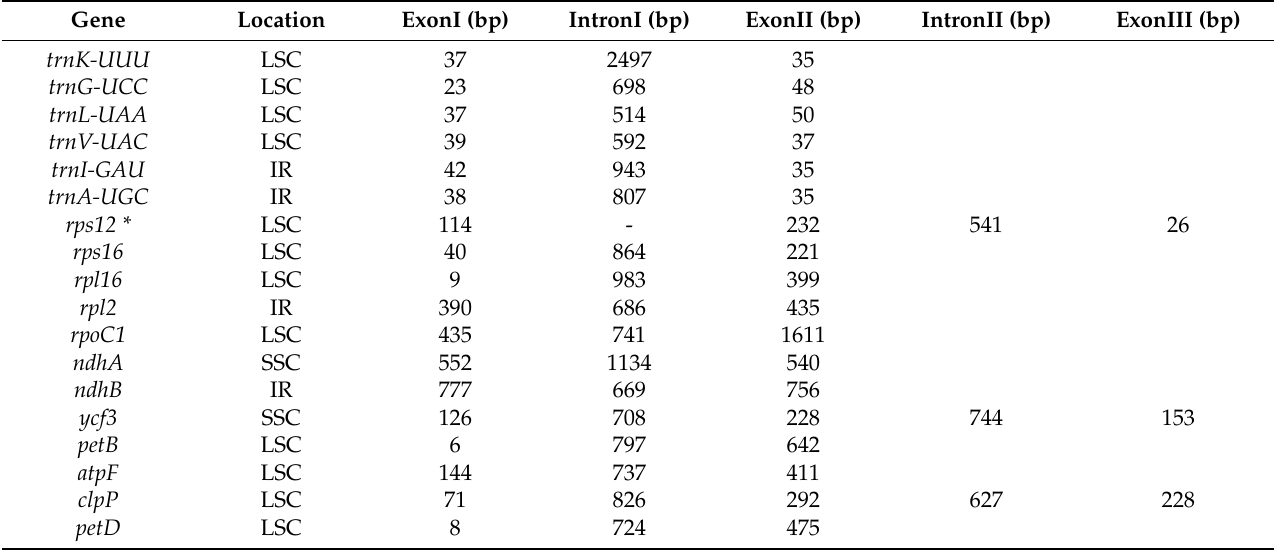
Table 3. Location and length of intron-containing genes within the M. hupehensis chloroplast